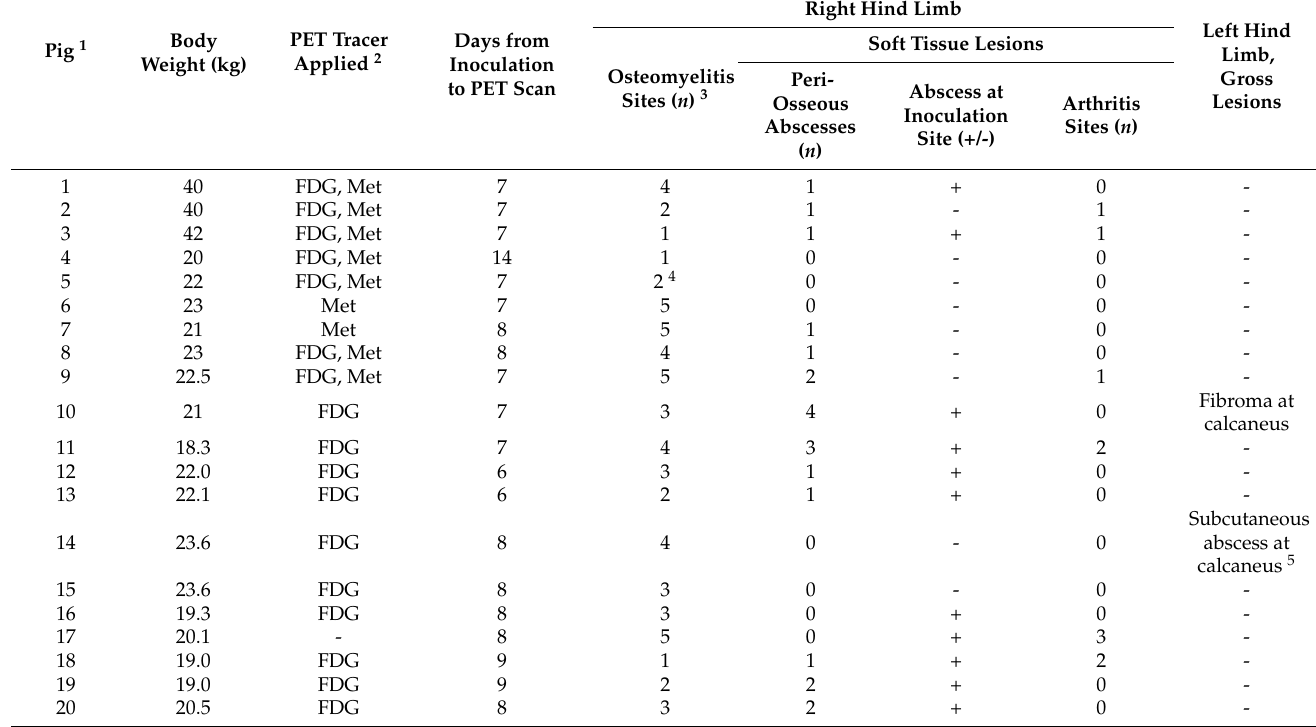
Figure 3. Inoculation abscess. A photo of a chronic lesion as identified by abscesses with peripheral capsular formation (arrow) at the inoculation site in between muscle tissue above the right femoral artery. Table 1. PET/CT scans and lesions by pathology.